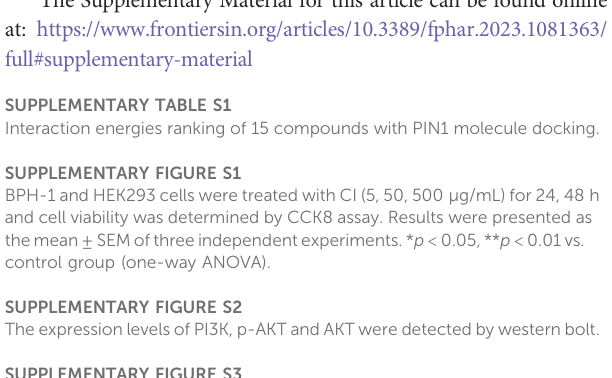
SUPPLEMENTARY FIGURE S3 Docking simulations of PIN1 and 13 potential candidate compounds and